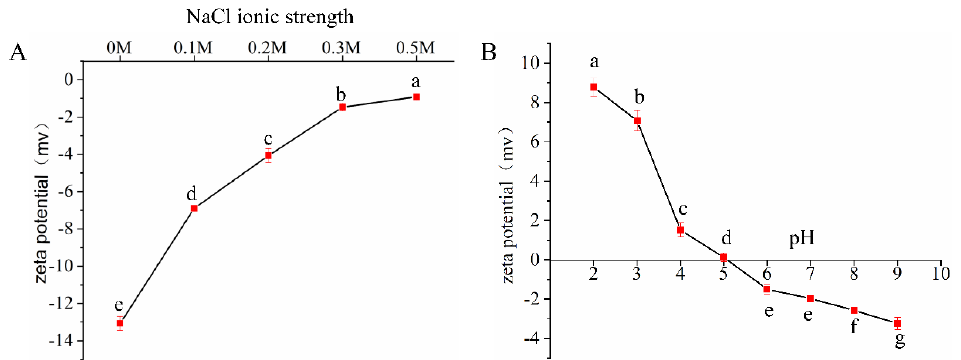
Figure 1. Zeta potential of EYGs at different NaCl ionic strength ( A ) and at a NaCl ionic strength of 0.3 M with different pH ( B ). Each value represents mean ± standard deviation (SD) of triplicates.